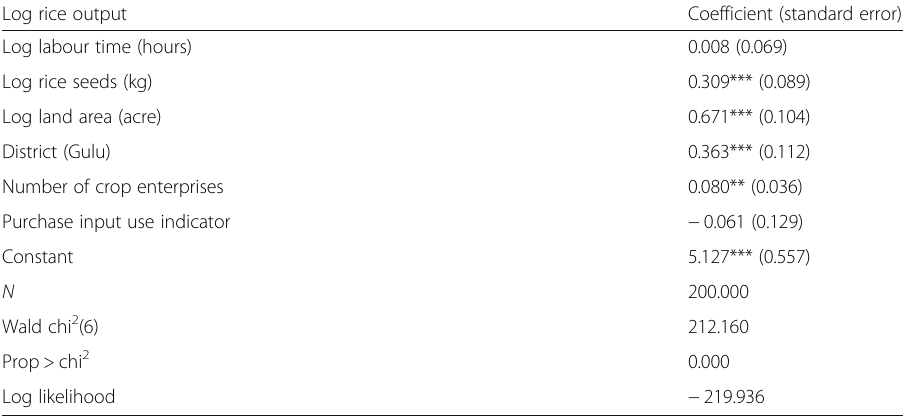
Table 2 Results of the Cobb-Douglas stochastic production function estimation Log rice